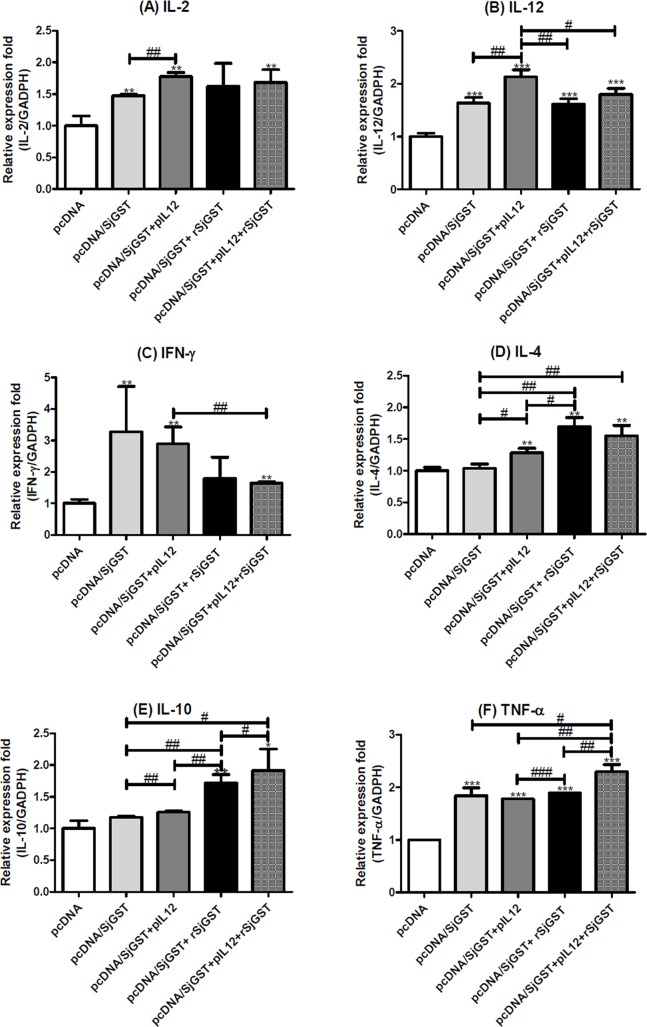
The cytokine mRNA expression levels in spleen cells after infection.Spleen immune cells were isolated from the spleen of mice 8 weeks after infection. The mRNA expression levels of (A) IL-2, (B) IL-12, (C) IFN-γ, (D) IL-4, (E) IL-10, and (F) TNF-α were measured by qRT-PCR. Comparative CT was used to determine the individual relative mRNA expression levels (fold differences) when normalized to the expression level of the internal control genes, GAPDH and 18s. The cytokine gene expression level of the pcDNA4 group was used as background to determine the relative expression. The results are shown as the mean ± standard deviation from three independent experiments. *: p < 0.05; **: p < 0.01; ***: p < 0.001, compared with the control group treated with pcDNA4. #: p < 0.05; ##: p < 0.01; ###: p < 0.001, compared between the two indicated groups.